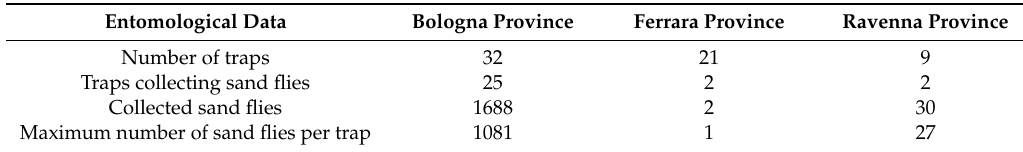
Table 1. Entomological data employed to implement the model with reference to the provinces where sand fly collection took place (July–August